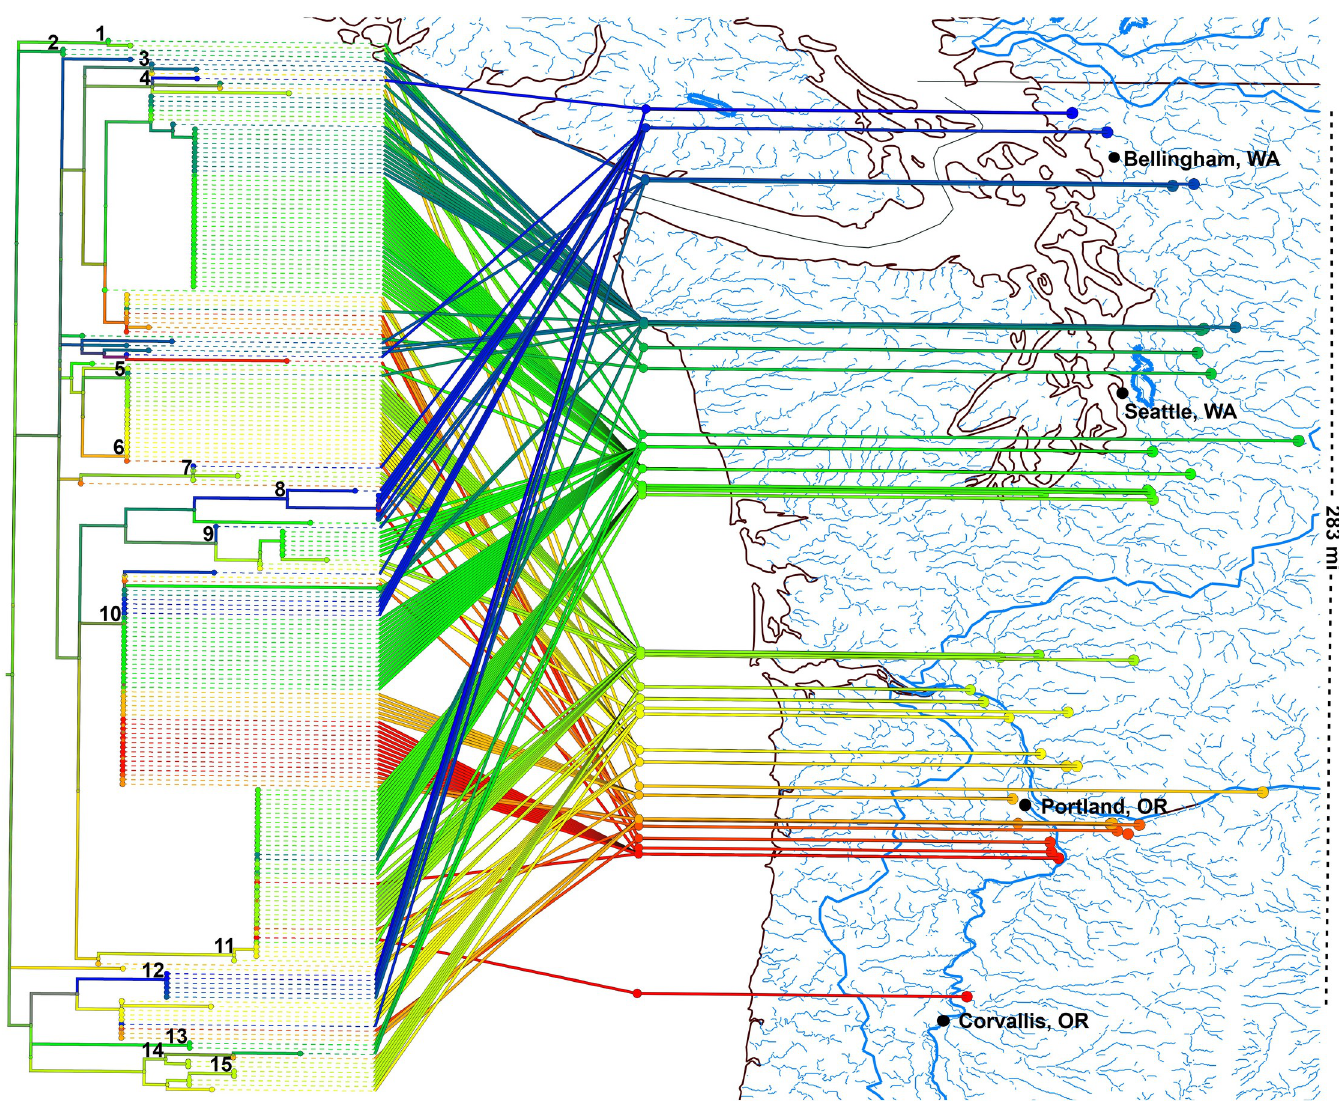
Fig 1. The Pacific Northwest (PNW) isolate GAPDH RAxML phylogeny mapped by latitude to the PNW region. Clades with > 80% bootstrap support values are indicated above the associated clade. A total of 15 clades encompassing 155 isolates were identified in the PNW isolate collection, with 74 isolates remaining unresolved. Isolates from smaller clades tended to group by region of origin with a few notable exceptions present over large north-south